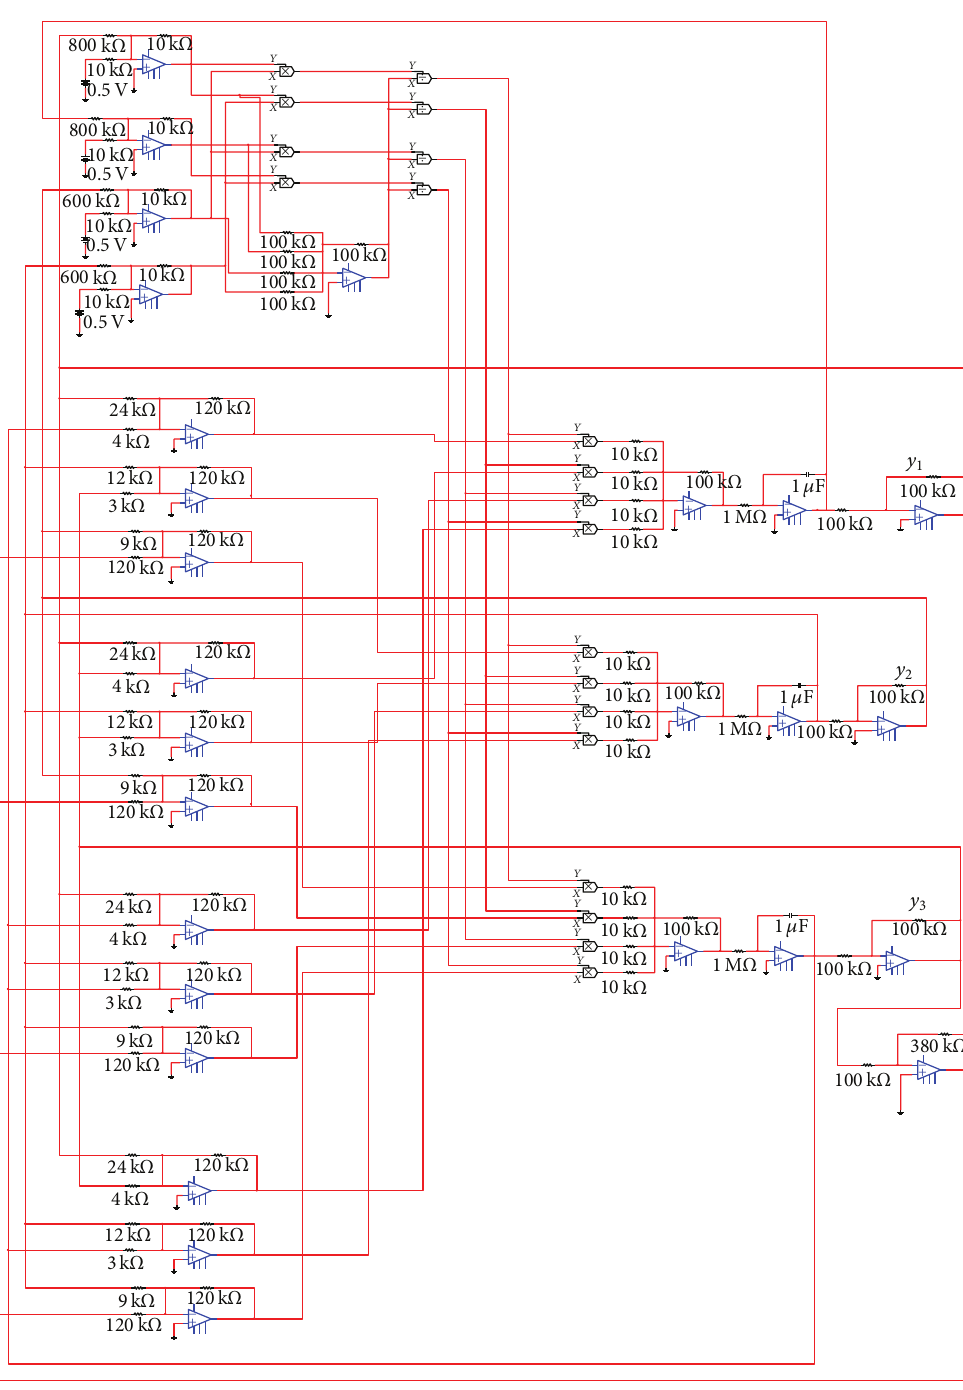
Figure 4: The fuzzy electronic circuit for chaotic Chen-Lee